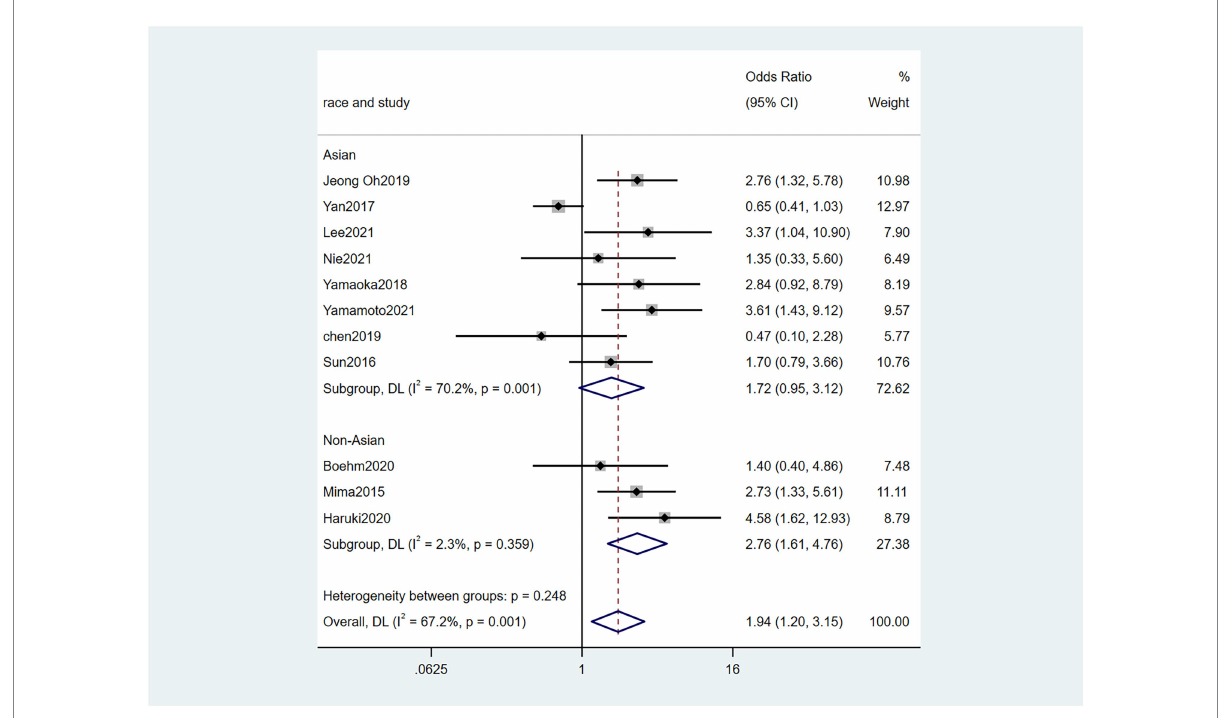
FIGURE 4 Forest plot of the relationship between Fusobacterium nucleatum and infiltration depth(pT) in cancer.